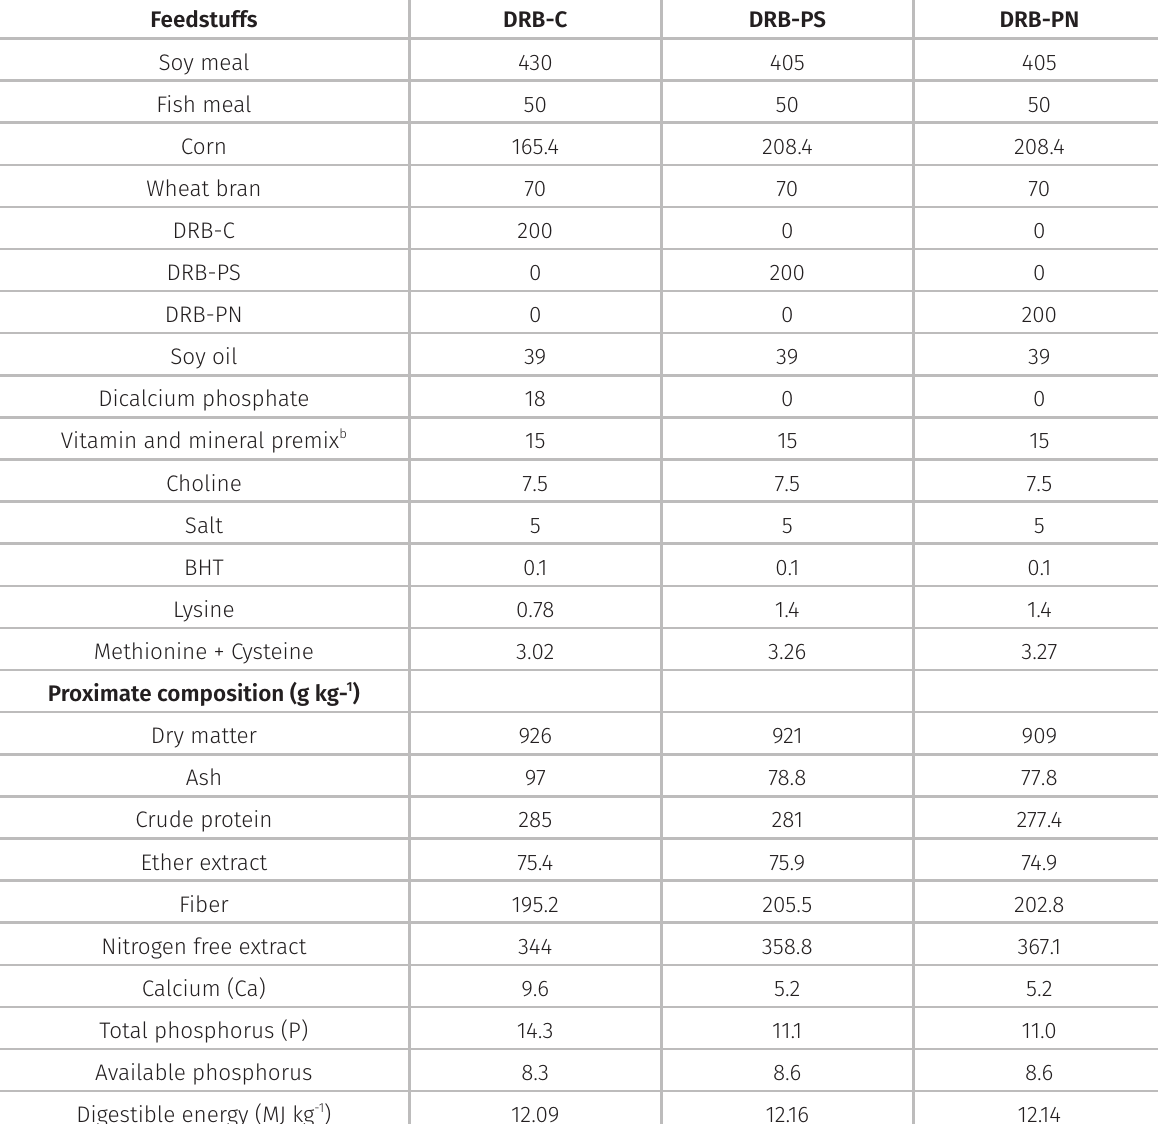
Table I. Composition of the experimental feeds (g kg -1 diets) a